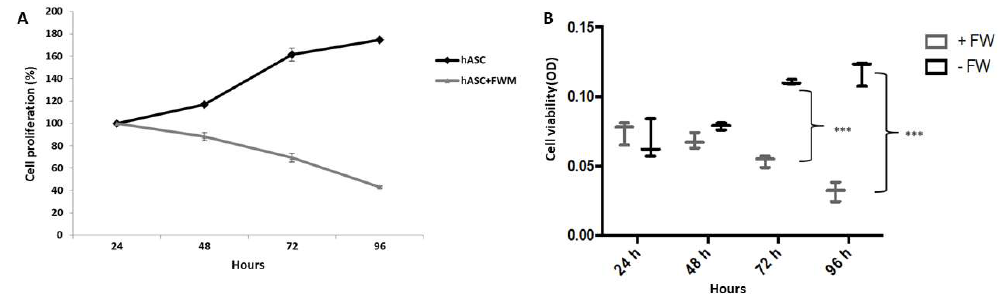
Figure 2. MTT viability assay. Regression ( panel A ) and Box plot ( panel B ) of hASC viability maintained in presence or not of FWM. hASCs were grown in the presence (grey line) or absence (dark line) of FWM at different time points (24, 48, 72 and 96 h) after plating. FWM results in a decrease of cell viability of hASCs. Statistical analysis was conducted according to Bonferroni’s test. *** p ≤ 0.001 (n = 3).